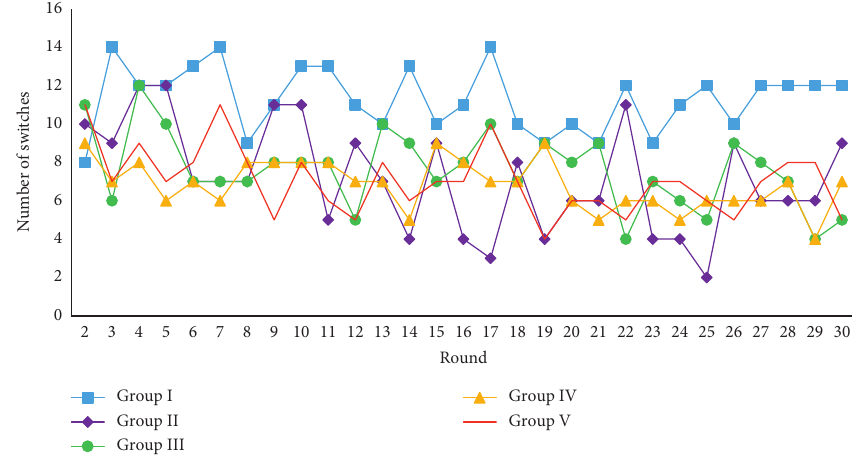
Figure 4: Distribution of number of route switches. Table 4: Cox-Stuart trend test ( α � 0.05). Group